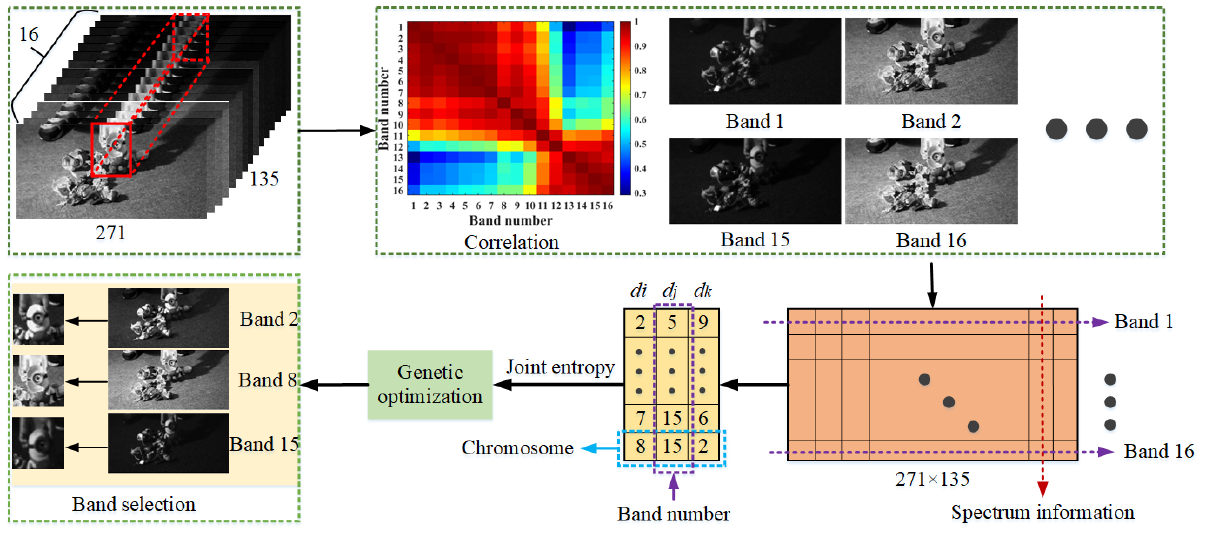
Figure 3. Band selection for the first toy1